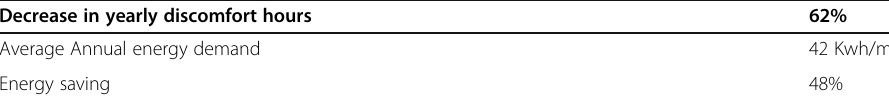
Table 9 Best-case analysis. By: researcher